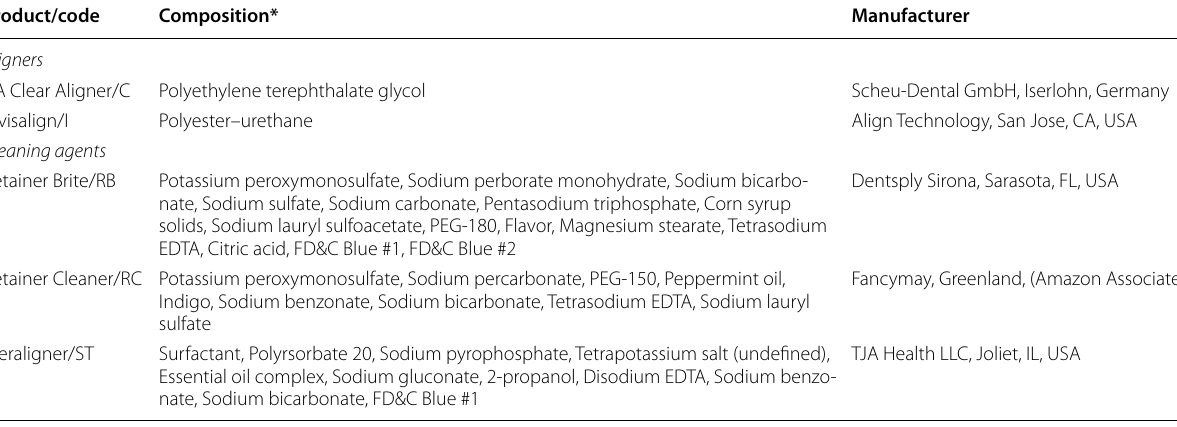
Table 1 The aligner materials and the cleaning agents used in the